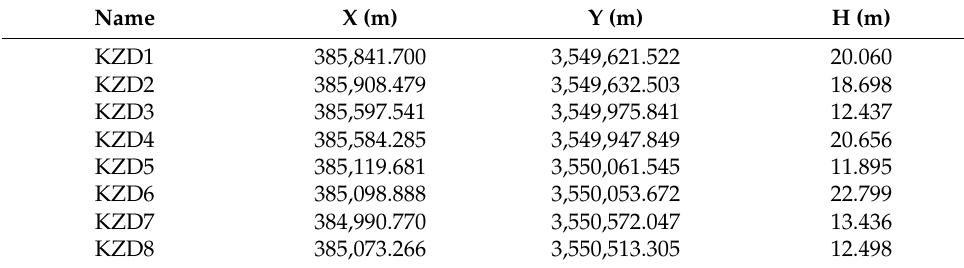
Table 2. Coordinates of ground control points.